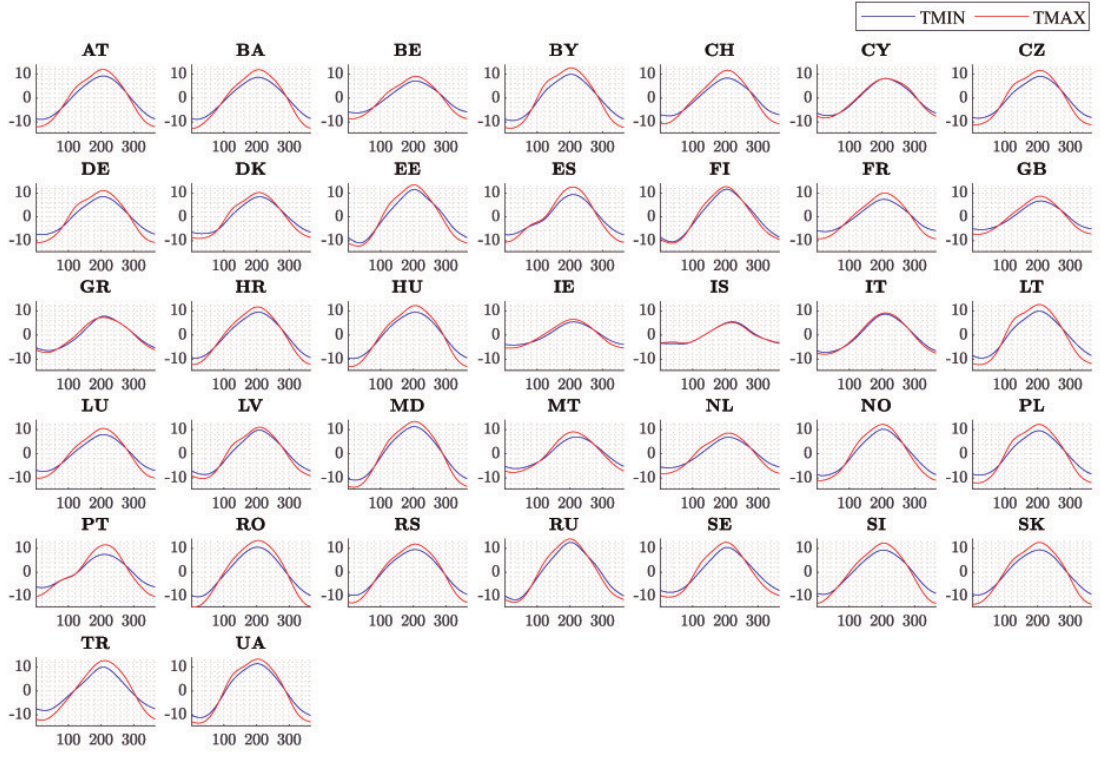
Figure A3. Seasonal component obtained with the GAM model for the 37 reference European weather stations and the minimum and maximum